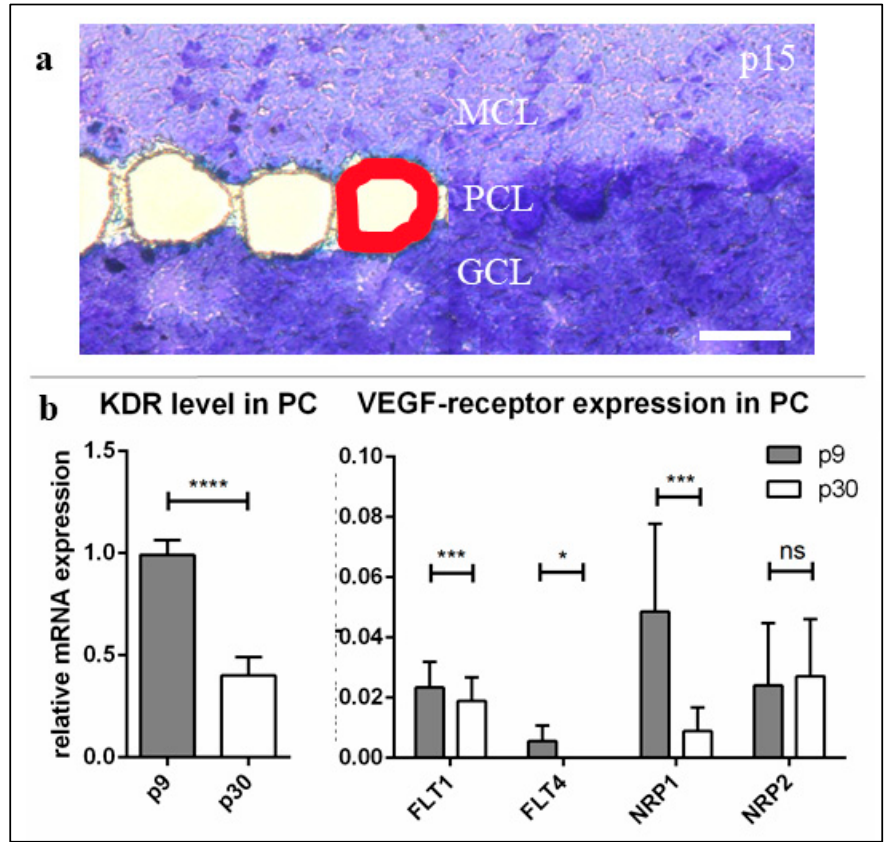
Figure 1. mRNA-expression levels of vascular endothelial growth factor (VEGF)-receptors in the course of Purkinje cells (PC) development. P9, ( a ) p9, p15, and p30 PCs were laser microdissected (red line) at 20x magnification and subjected to the method of qRT-PCR. ( b ) For relative quantification of FLT1 (VEGFR-1), KDR (VEGFR-2), FLT4 (VEGFR-3), NRP1 and NRP2 , the 2 (– ΔΔ Ct) method was conducted using GAPDH for normalisation. Relative mRNA expression is shown in relation to KDR at p9. Data are provided as means ± SEM and were tested for significance using Student’s t-test. Significant differences are indicated by ns ( p > 0.05), * ( p ≤ 0.05); *** ( p ≤ 0.001), **** ( p ≤ 0.0001), n = 3. Scale bar: ( a ) 50 µm.